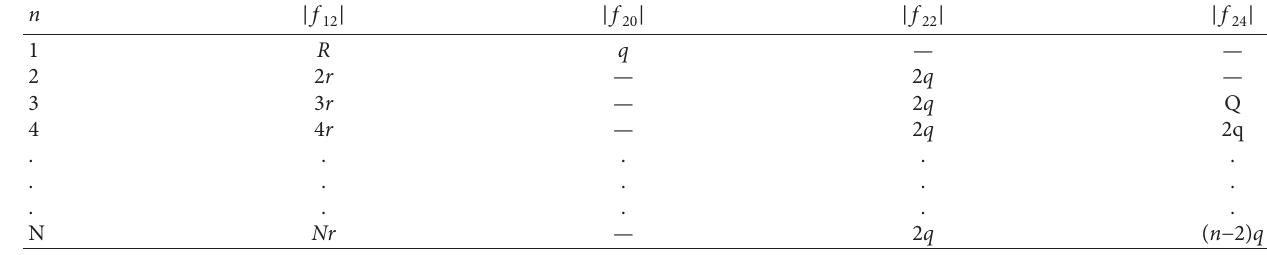
C ( S )[ 7 , 4 , 4 ] . (b) 3D nanotube TUC 4 8 , f , f , and f with given number of rows. 12 20 22 24